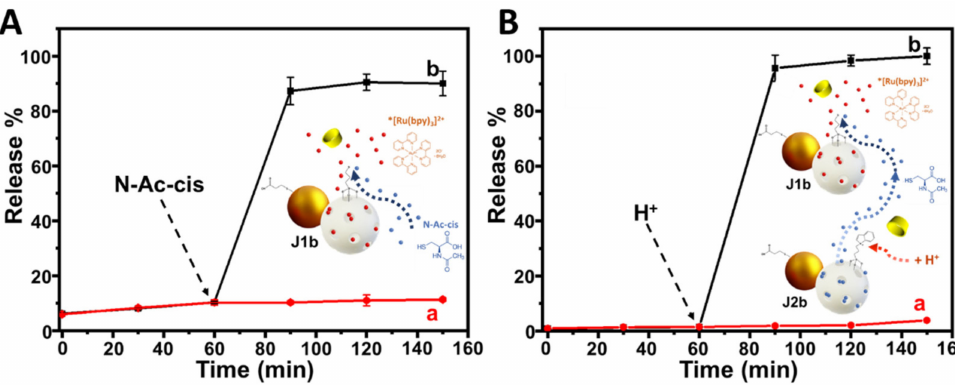
Figure 3. Cargo release assays control assays: ( A ) Kinetics of [Ru(bpy) 3 ] 2+ release encapsulated in J1b in the presence of 50 mM N-acetyl-L-cysteine. ( B ) Kinetics of [Ru(bpy) 3 ] 2+ release encapsulated in J1b in the presence of J2b and the addition of acid media. (Conditions: 20 mM Na 2 SO 4 , pH 7.5, 25 ◦ C, [J1b] = 3 mg mL − 1 , [J2b] = 3 mg mL − 1 , λ abs = 454 nm). Error bars correspond to the s.d. from three independent